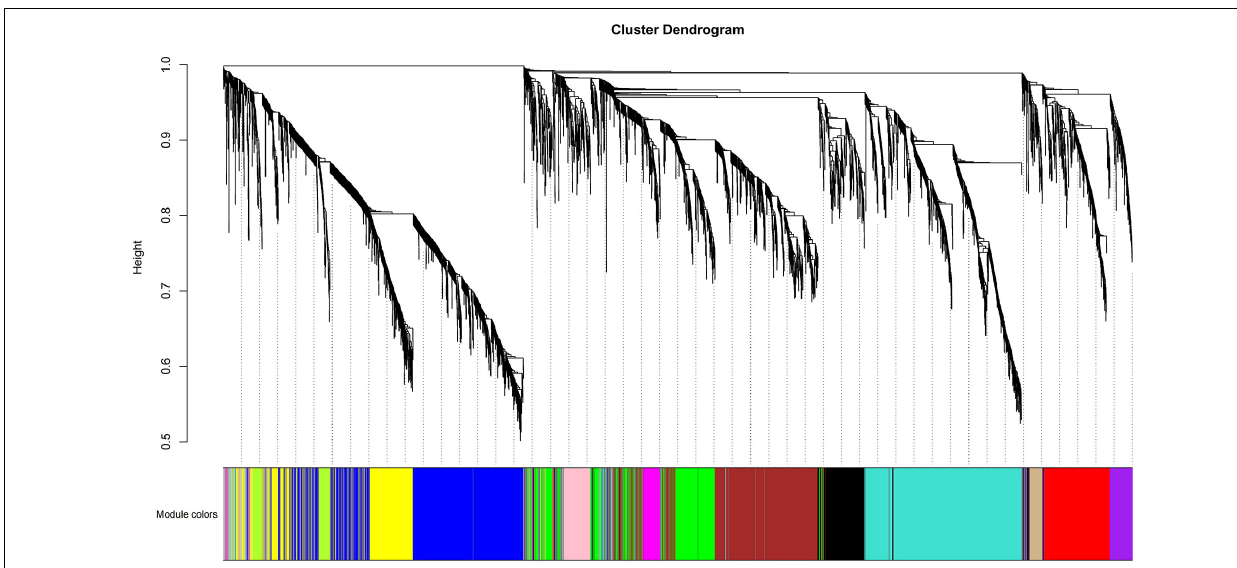
FIGURE 7 | The cluster dendrogram of coexpressed genes.